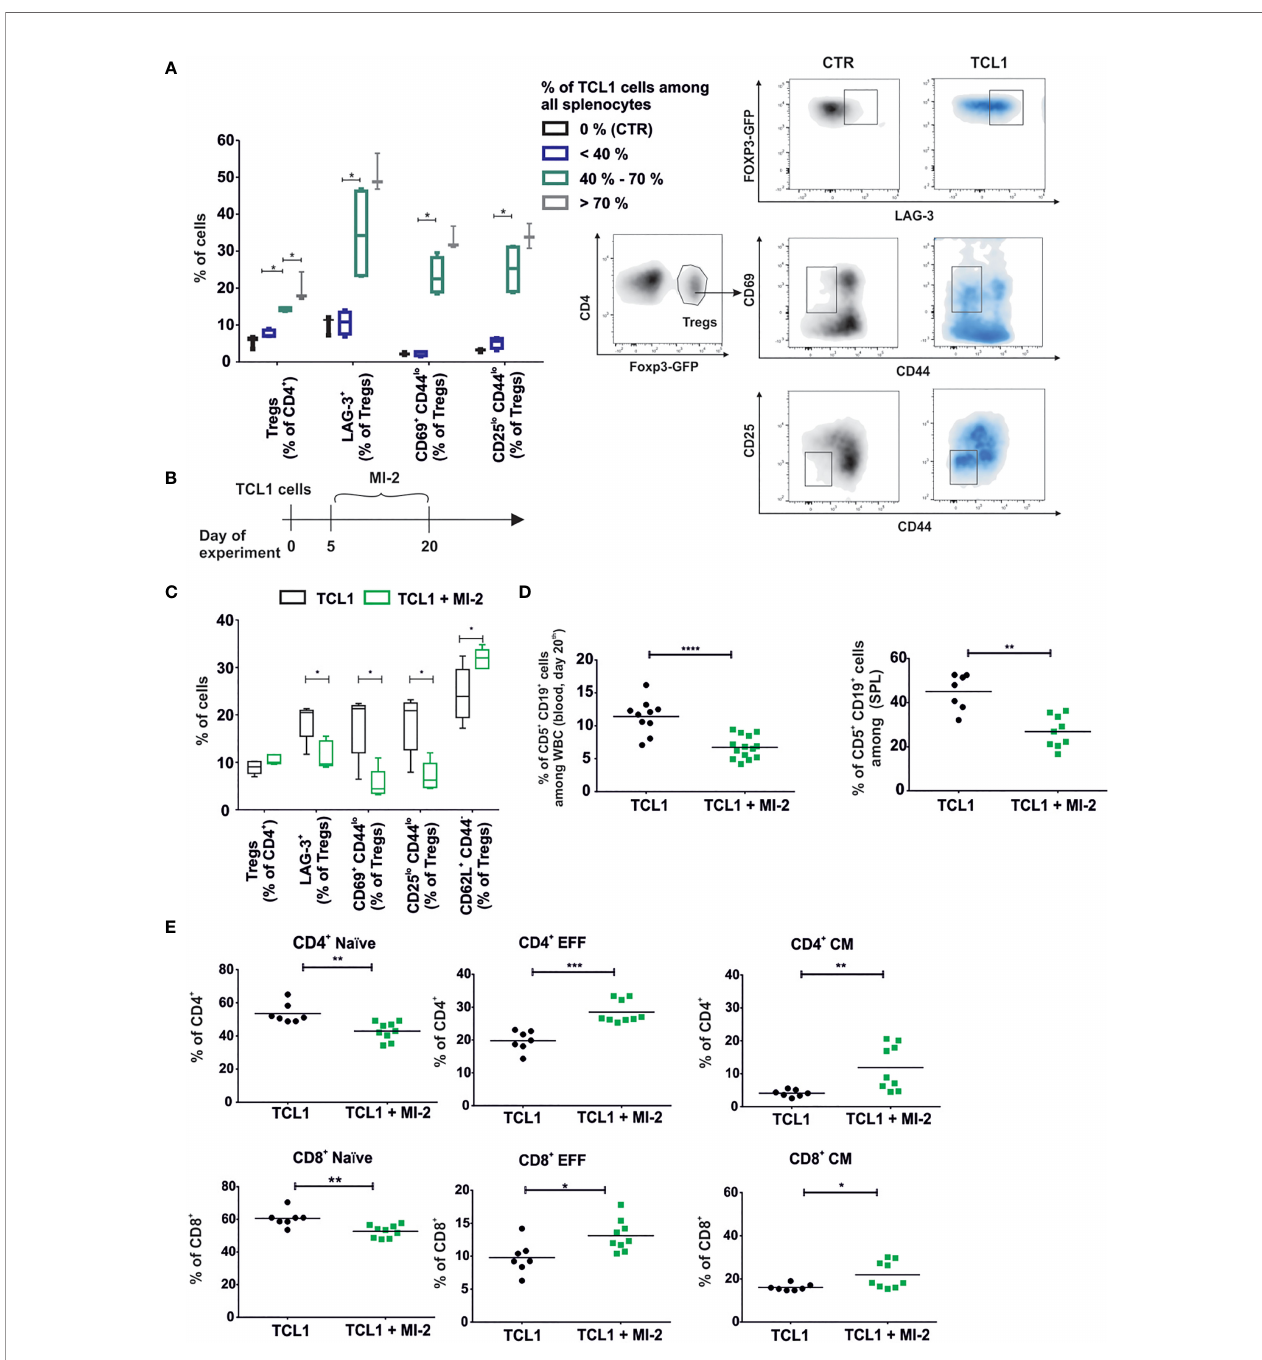
FIGURE 5 | Development of a speci fi c TCL1-related Tregs (Tregs A) population is correlated with the stage of the disease and can be blocked by MALT-1 inhibitor. (A) The box plot min-max graph (left panel) and density plots with gating strategy (right panel) present phenotype of Tregs in relation to the percentage of leukemic cells (CD5 + CD19 + ) in the spleens. Mean ± SD, n=11, Mann-Whitney U test *p ≤ 0.05. (B) The graph presenting a scheme of the experiment. MI-2 was administered daily at dose 20 mg/kg via intraperitoneal injections for two weeks. (C) The phenotype of Tregs collected from spleens of TCL1 leukemia-bearing B6 Foxp3 EGFP mice, untreated (TCL1) or treated with MI-2(TCL1 + MI-2). Mean ± SD, Mann-Whitney U test n = 5, *p ≤ 0.05. (D) Percentage of leukemic cells (CD5 + CD19 + ) assessed by fl ow cytometry in blood (left graph) and spleens (right graph) on day 21 st of the experiment. The graph presents data from three (blood, n = 10-14) or two (spleens, n = 7-8) independent experiments. Each dot represents an individual sample (mouse), means, Mann-Whitney U test **p ≤ 0.01, ***p ≤ 0.001, **** p < 0.0001. (E) The percent of naïve, effector (EFF), central memory (CM), subpopulations of CD4 + and CD8 + T cells. Cells were collected from spleens of untreated and MI-2-treated TCL1 leukemia-bearing B6 Foxp3 EGFP mice in two independent experiments, n = 7-12. Each dot represents an individual sample (mouse), means, Mann-Whitney U test *p ≤ 0.05, **p ≤ 0.01, ***p ≤